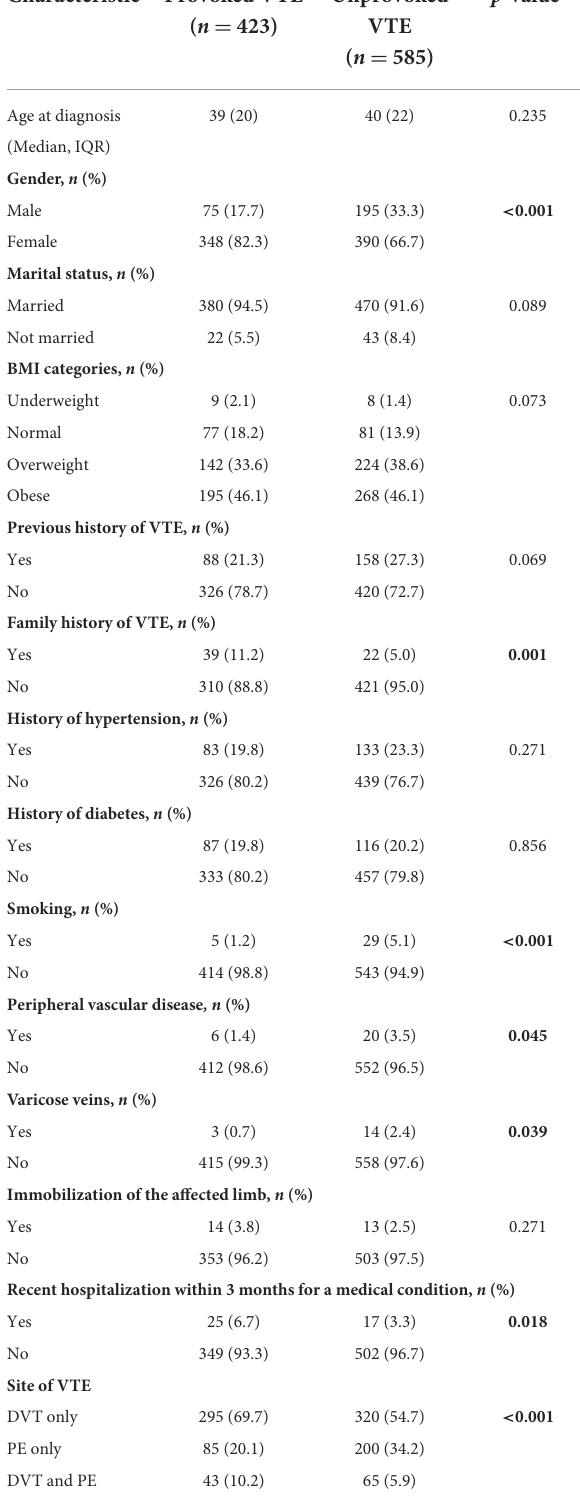
With respect to outcomes in the ICU, four of nine DVT